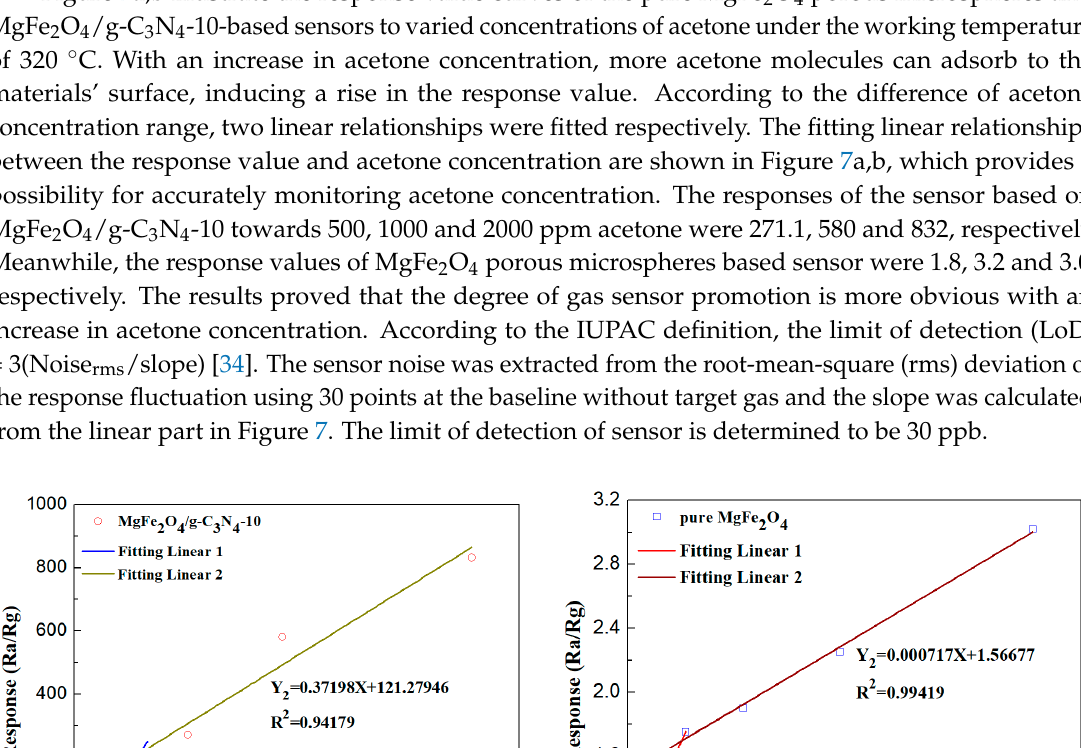
Figure 8. Response values of the sensors based on MgFe 2 O 4 and MgFe 2 O 4 /g-C 3 N 4 -10 to 500 ppm of different types of tested gas at working temperature of 320 °C.